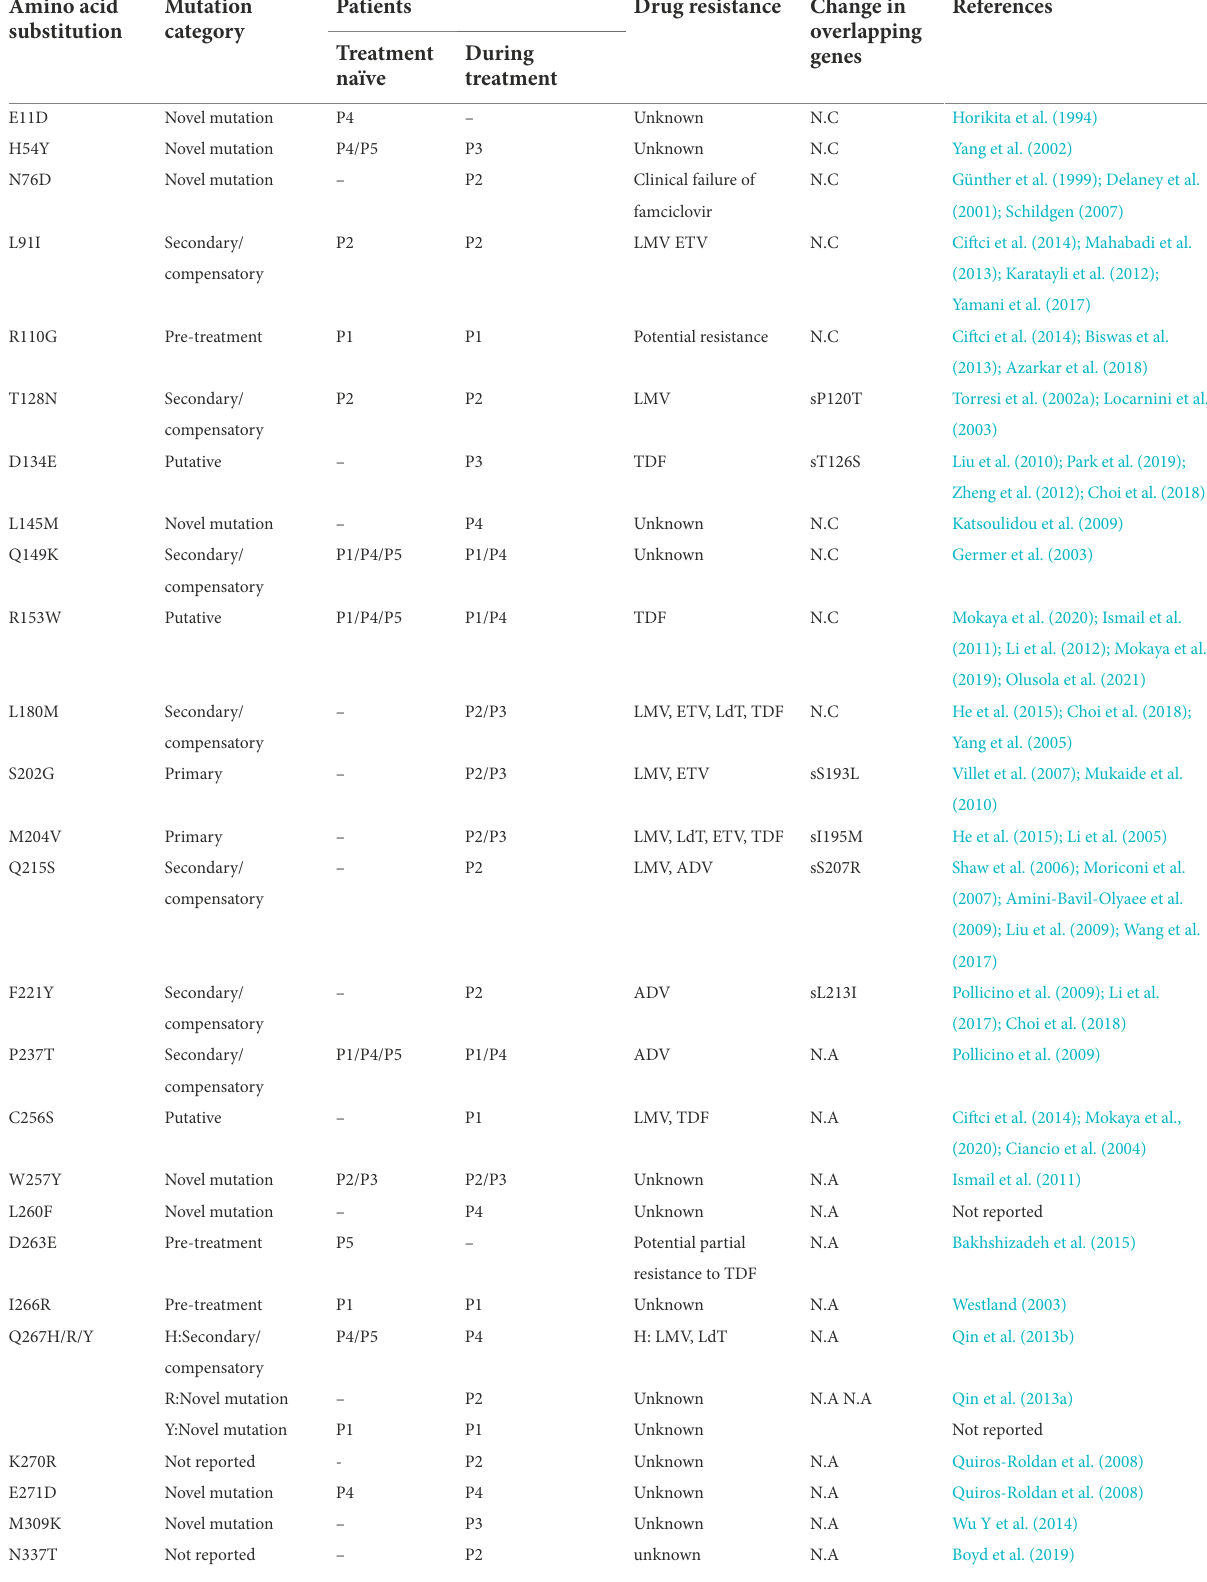
TABLE 2 Amino acid substitutions detected within the RT region sequences of the five HBV Chronic infected patients with their reported antiviral resistance. Amino acid Mutation Patients Drug substitution category